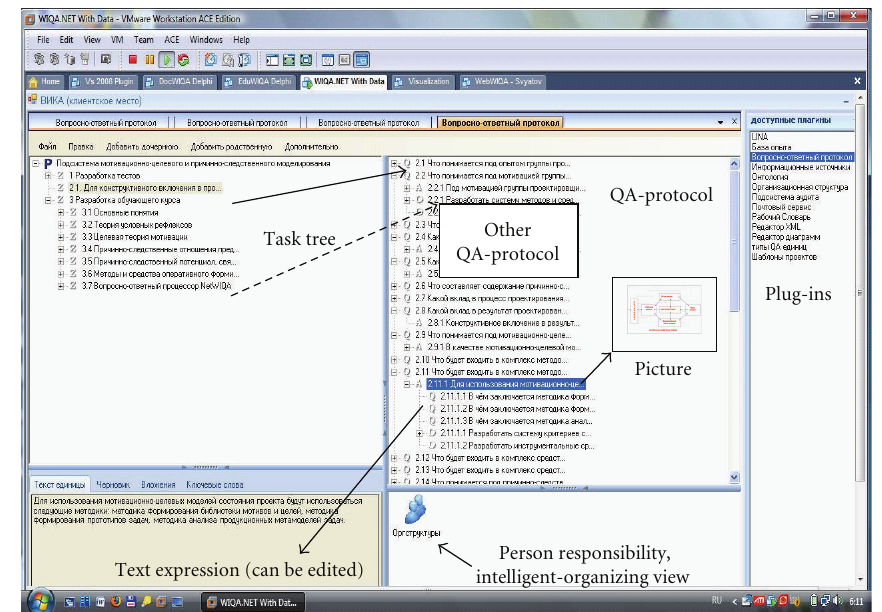
Figure 6: Relation between logic-linguistic view and task